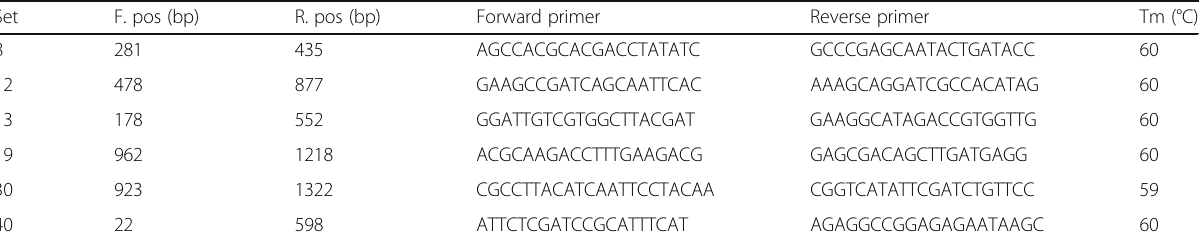
Table 7 Designed primer sets to differentiate biovar 4 from others